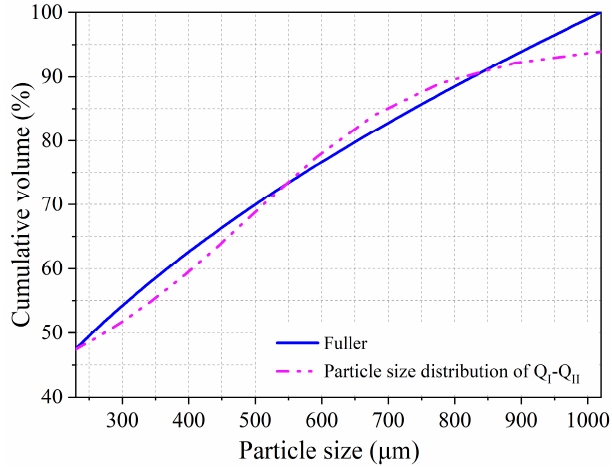
Figure 3. Particle size distribution of the aggregate system.